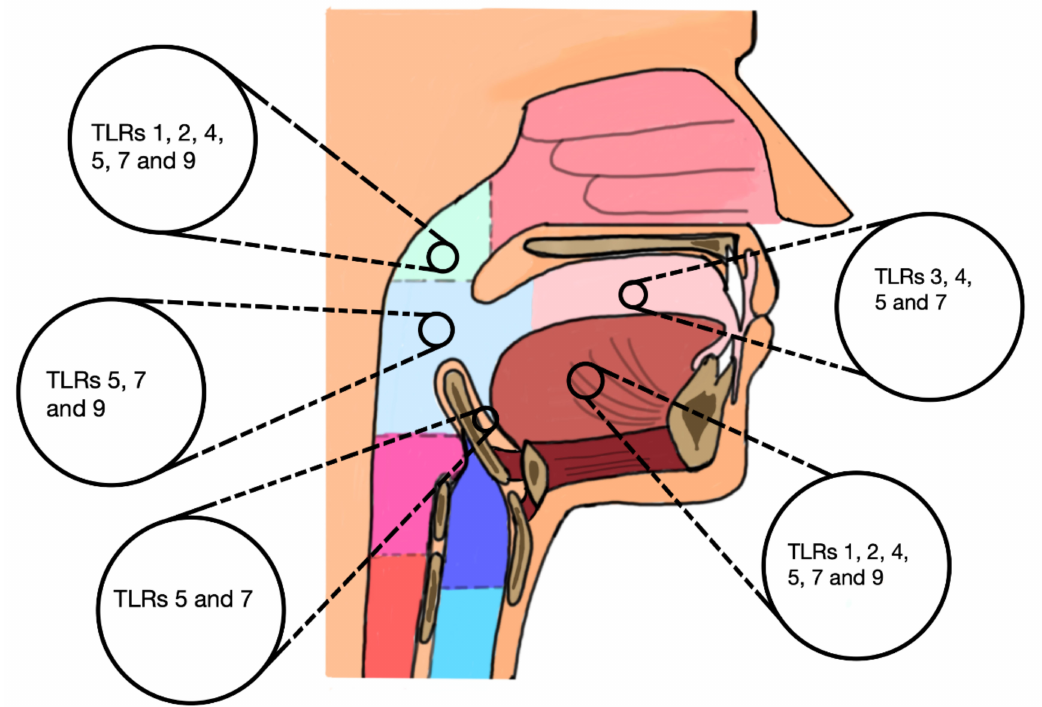
Figure 4. An illustration of the studied toll-like receptors (TLRs) in the corresponding tumour site of the head and neck squamous cell carcinoma patients included in the present